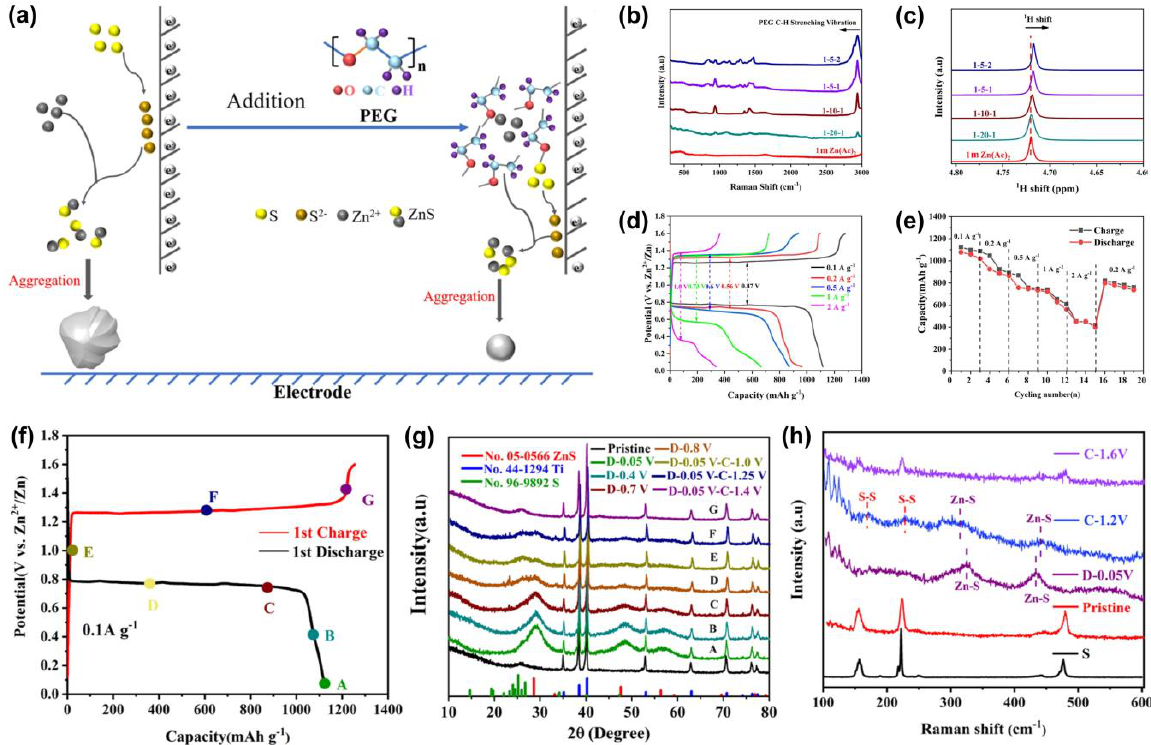
Figure 4. ( a ) Schematic of the effect of PEG additive; ( b ) Raman spectra and ( c ) 1 H NMR spectra of different electrolytes; ( d ) GCD curves and ( e ) capacity evolution at different current densities; ( f ) GCD curve at 0.1 A g − 1 and ( g ) corresponding ex situ XRD patterns; ( h ) Raman spectra of the S cathode at different charge/discharge states (Reproduced with permission from Ref. [63]. Copyright 2022,